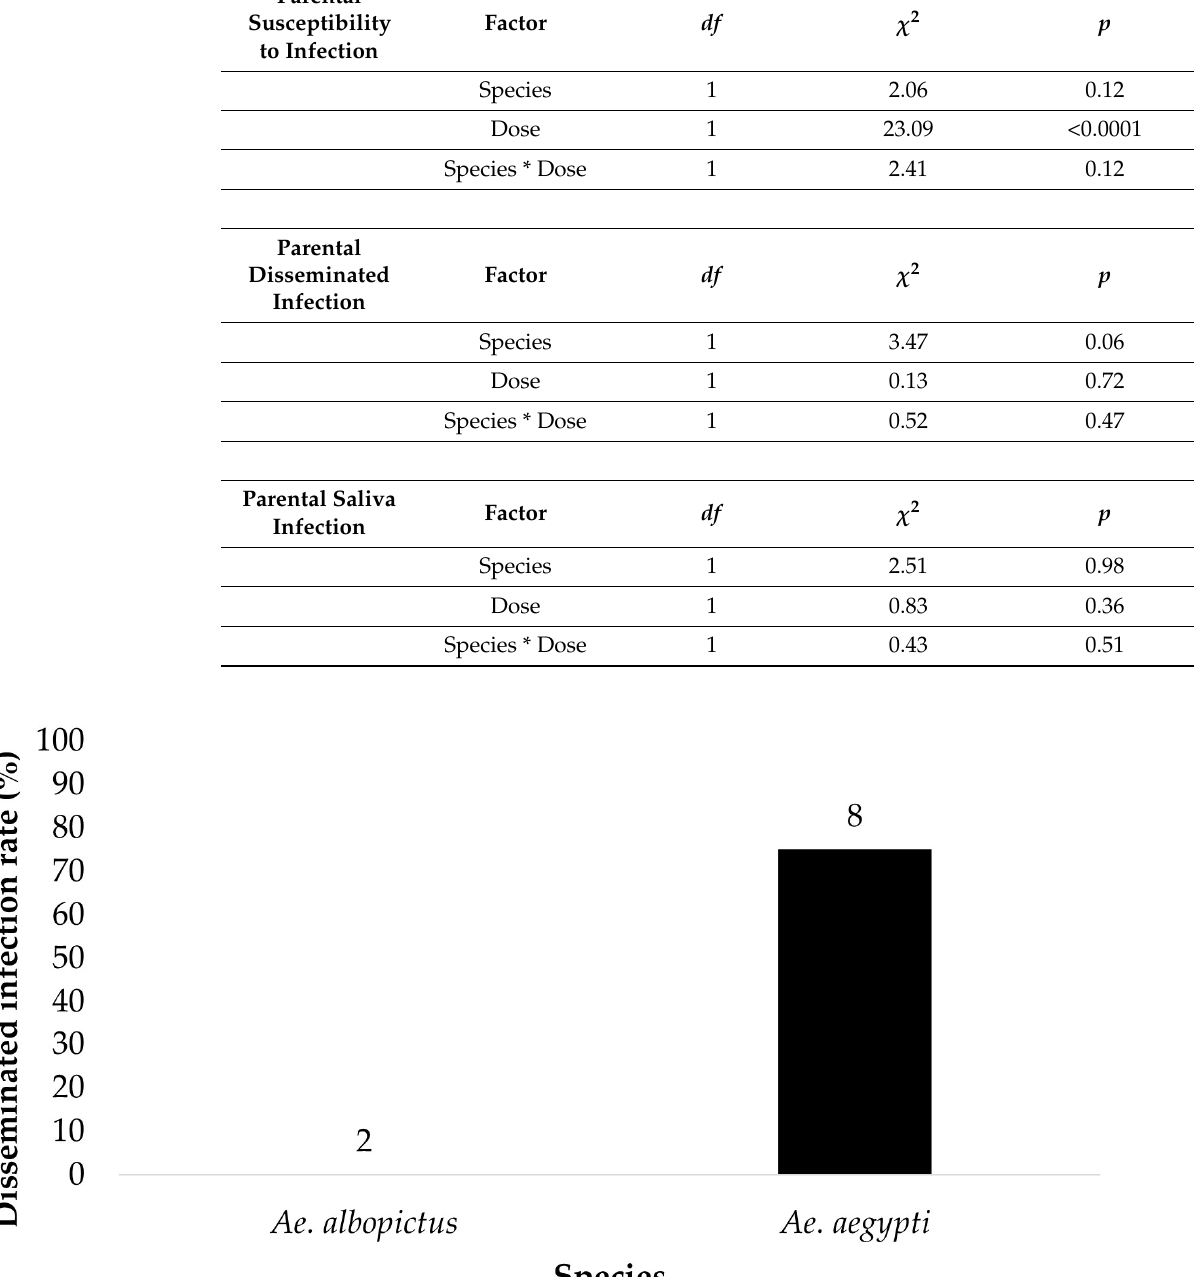
Figure 2. All bodies were tested for the presence of ZIKV infection. The results show the suscepti- bility to ZIKV infection of parental Ae. aegypti and Ae. albopictus from the treatment groups ingesting infected blood at a dose of 7 log 10 PFU/mL. The numbers above the bars represent the number of mosquitoes tested.